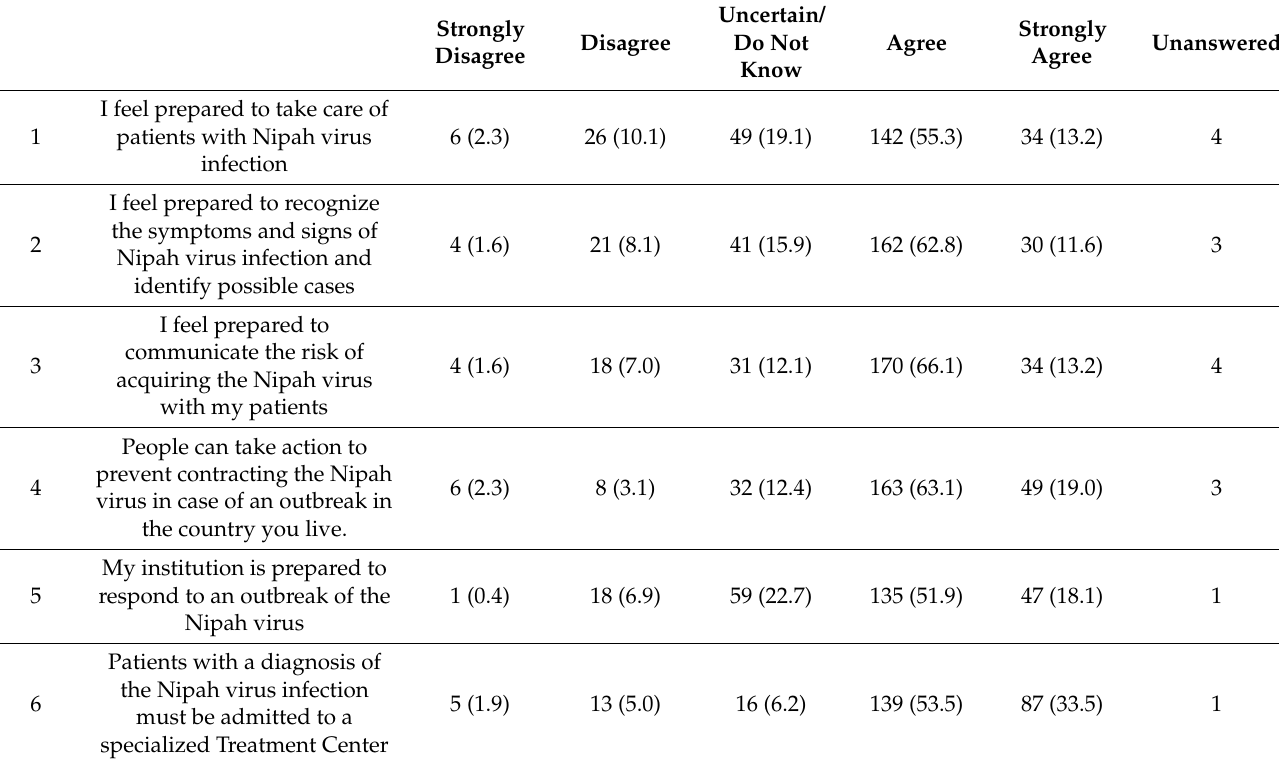
Table 7. Preparedness for Working with Patients with Nipah virus